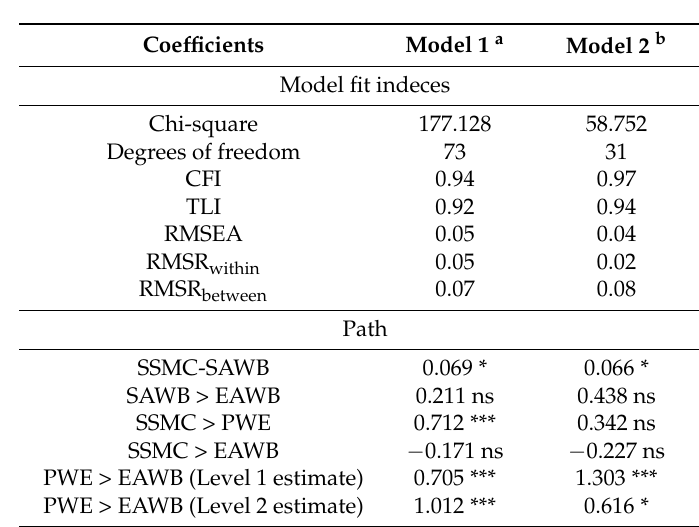
Table 3. Summary of the results obtained in relation to the tested mediation